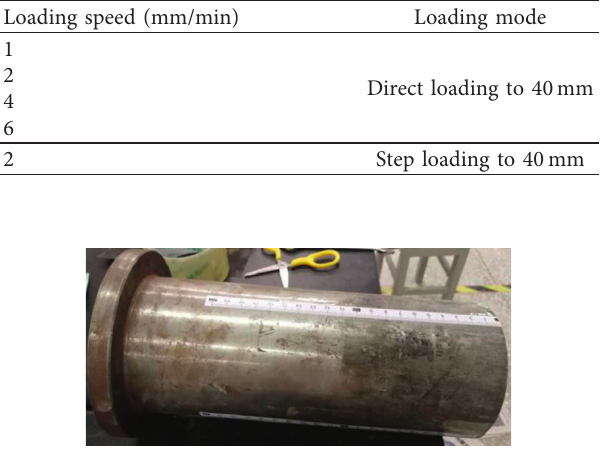
Table 2: Test scheme.